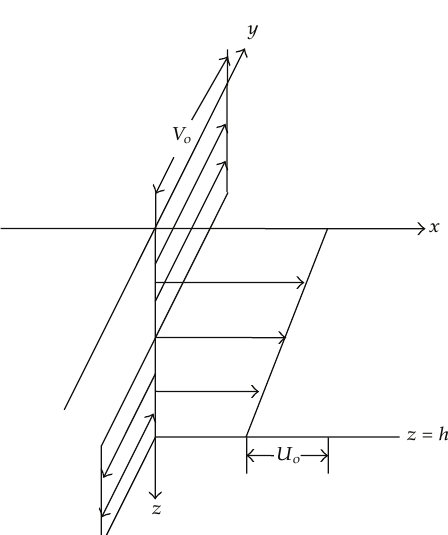
Figure 3: Representation of the shear flow on the continental shelf of the middle Atlantic bight (cid:6) 2 (cid:7) . (cid:4) 3.3b (cid:5) and (cid:4) 3.3c (cid:5) and the circulating direction of the secondary current, which was